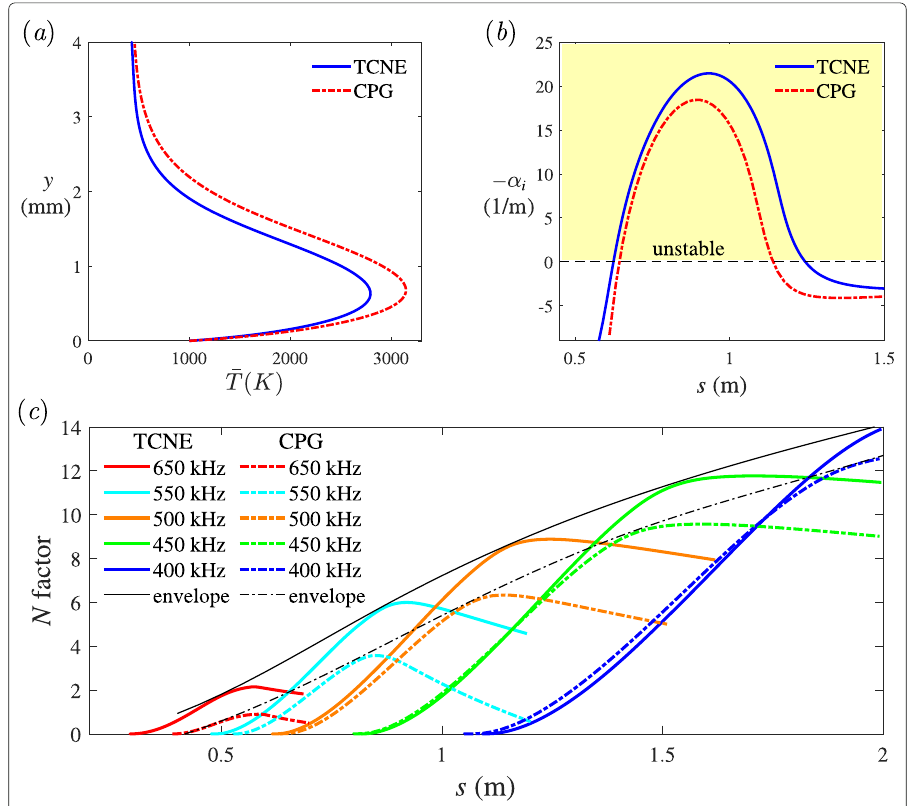
Fig. 11 Comparisons of ( a ) the laminar flow profile at s = 0.4m , ( b ) the growth rate curves with f of 500kHz and ( c ) the N factor curves between the TCNE and CPG